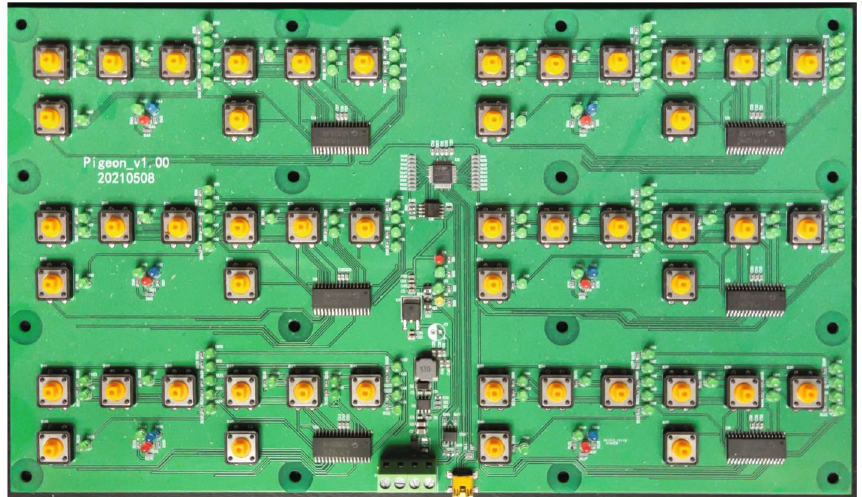
Figure 4. Circuit wafer.